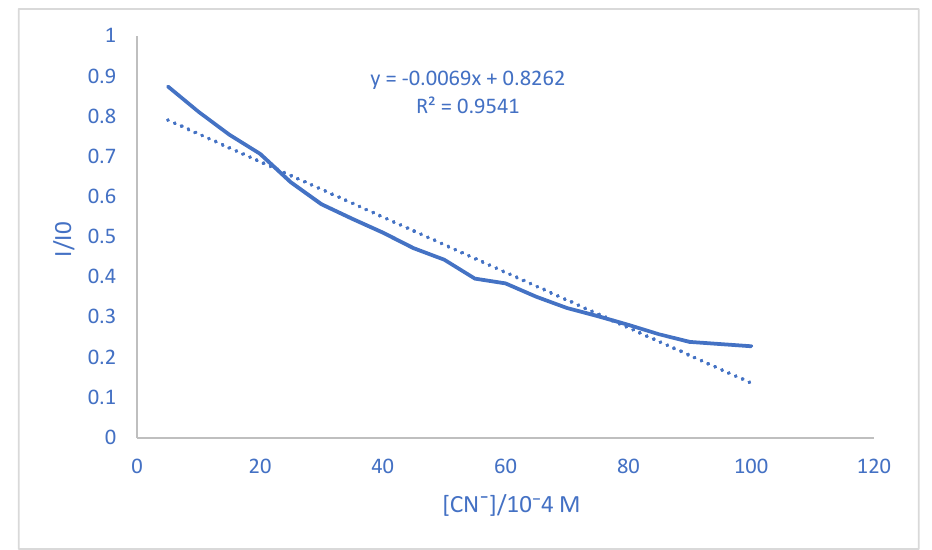
Figure 7. Stern–Volmer plot for the titration of fumed-Pr-Pi-TCT with different concentrations of CN − .